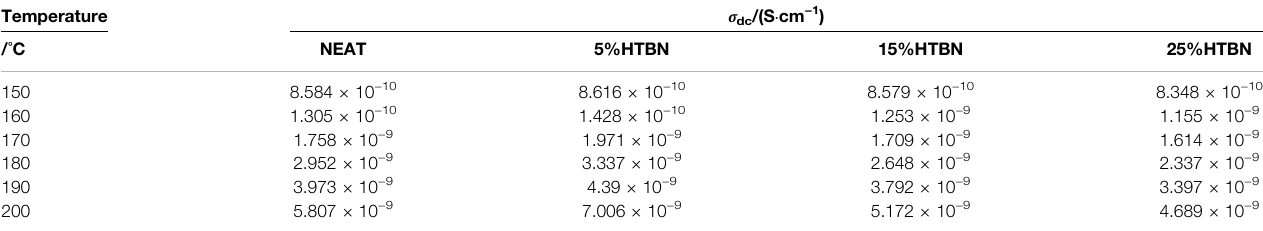
TABLE 2 | DC conductivity of different samples at high temperature.